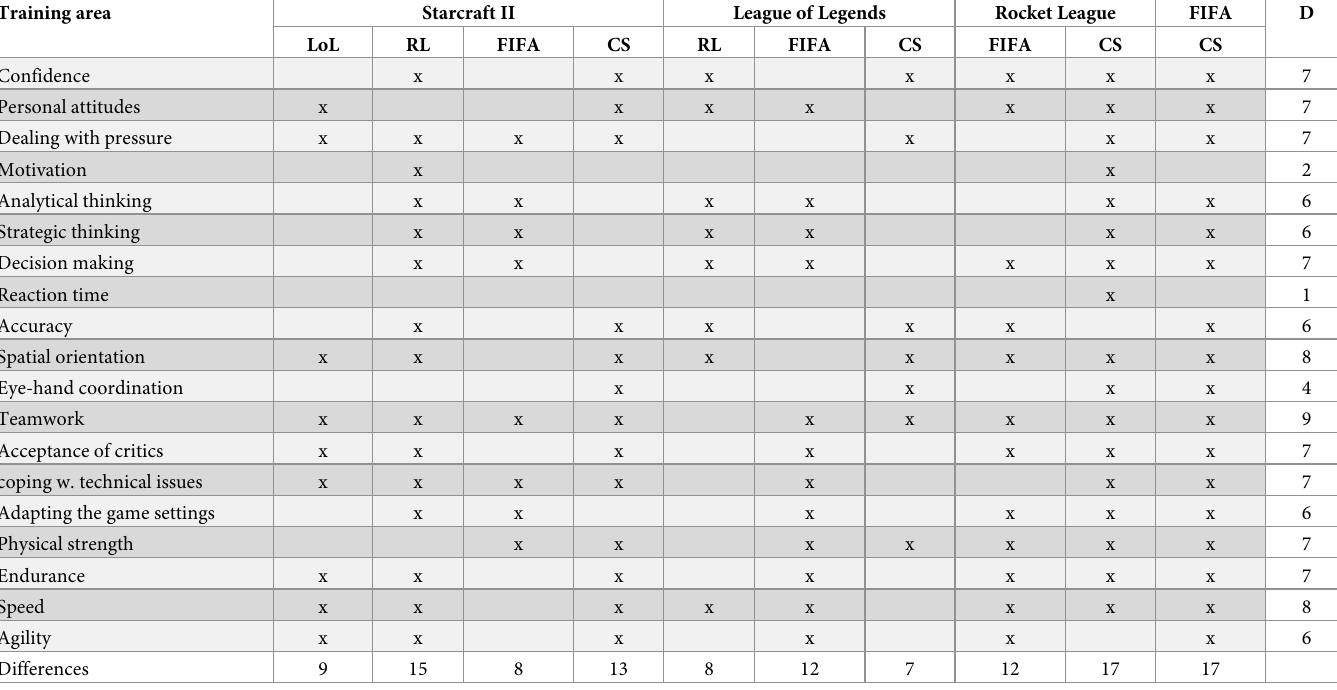
Table 14. Significant differences between the esports in the importance of specific training areas (LoL = League of Legends; RL = Rocket League; CS = Counter Strike; D = Differences). Training